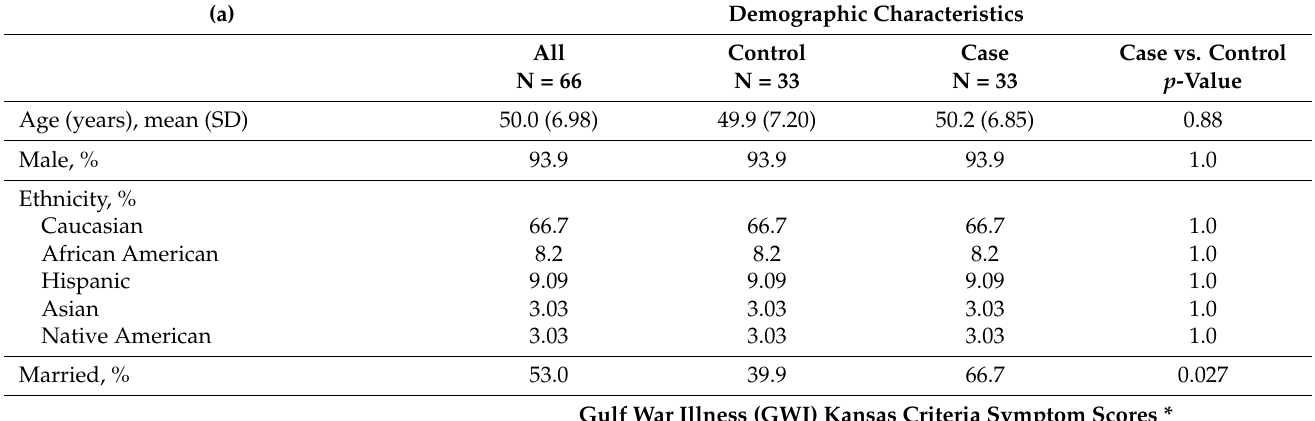
Table 1. (a) Participant characteristics: Full sample. (b) Participant characteristics: Subset with post-exercise phosphocreatine recovery time constant (PCr-R)